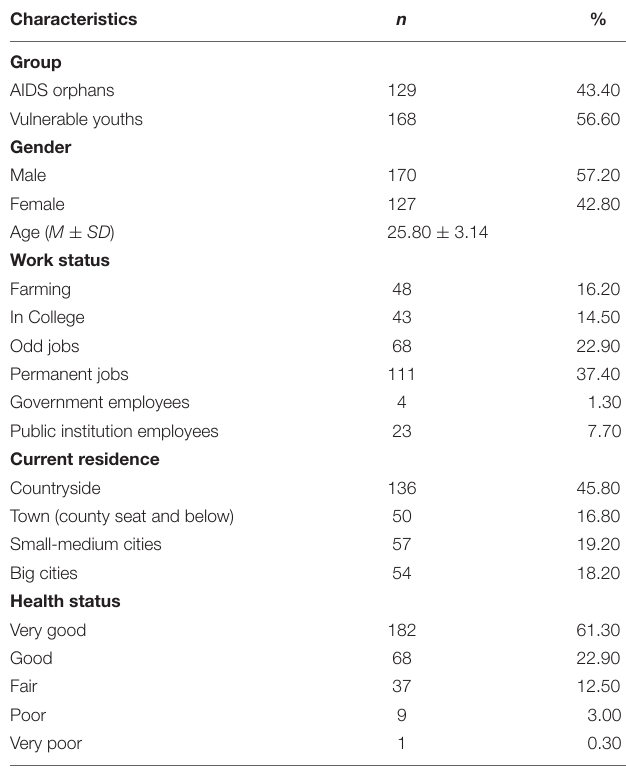
TABLE 1 | Background characteristics of the HIV-affected youths ( N =